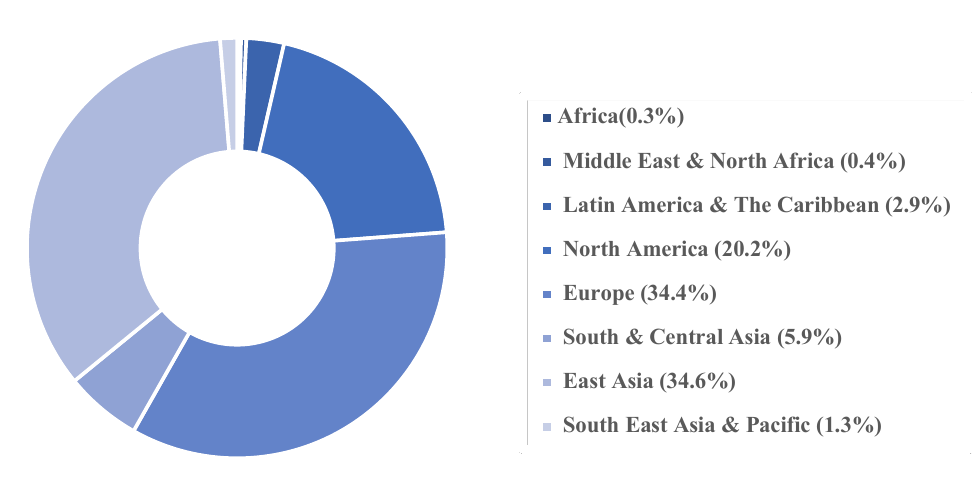
Figure 2. Wind installed capacity by region (IEA,